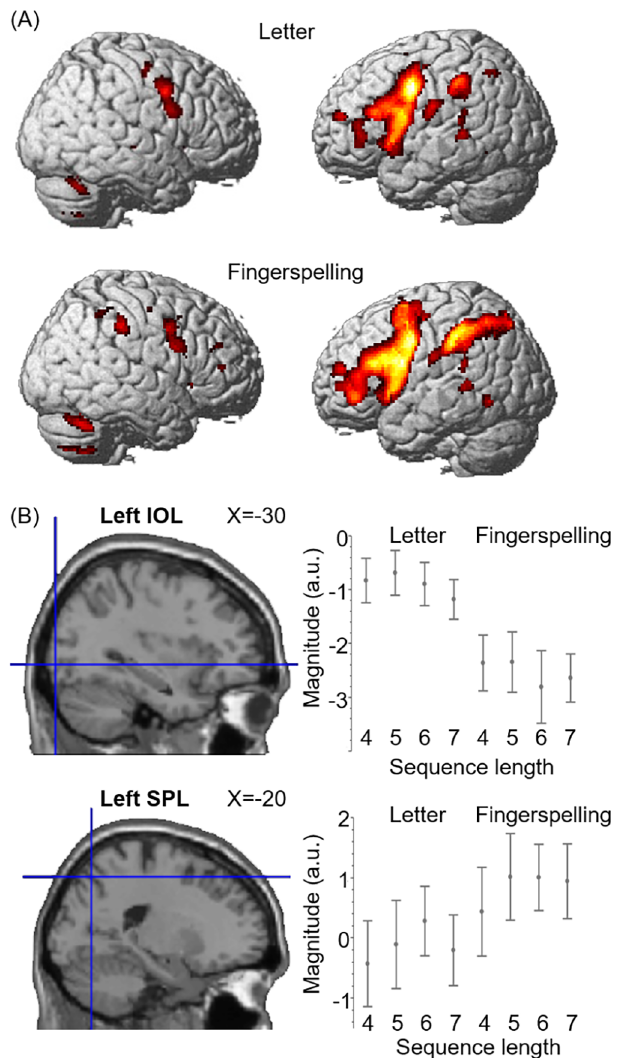
Fig 3. Overall pattern of activation during the maintenance stage. (A) Brain activationproduced by letter and fingerspellingstimuli. The letter and finger conditionboth producedleft-predominant activationin frontal- temporalregions. (B) Modality-specific activationduringthe maintenance stage. The left inferior occipital gyrus was more strongly activated for letters than for fingers (top). Conversely, the left superiorparietallobule was activated more greatly for fingers than for letters (bottom).